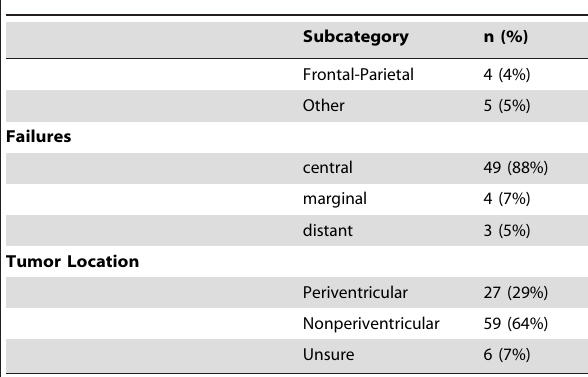
Table 1. Patient and Tumor Characteristics. Table 1. Cont.